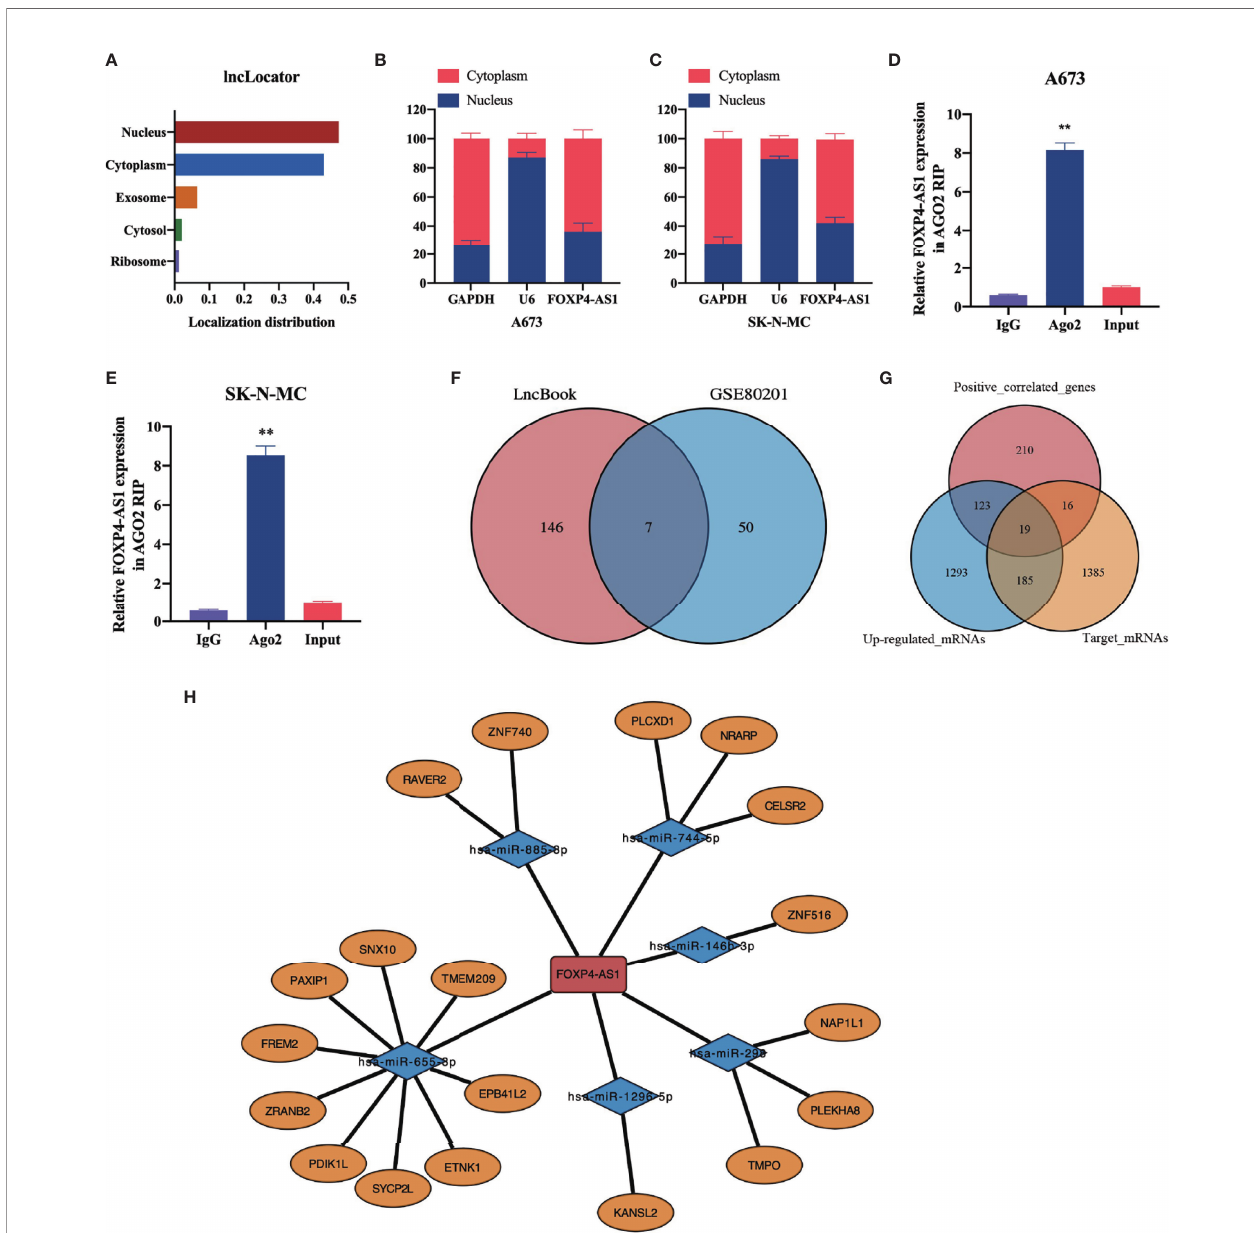
FIGURE 6 | Construction of a ceRNA modulatory network of FOXP4-AS1 in ES. (A) The subcellular localization of FOXP4-AS1 was predicted by the lncLocator tool. (B, C) Subcellular localization of FOXP4-AS1 was analyzed by nuclear and cytoplasmic separation experiments in A673 and SK-N-MC cells. (D, E) Ago2-IP experiment revealed that FOXP4-AS1 can bind to Ago2 and participate in the miRNA-mediated mRNA silencing function. Input represents a sample of the solubilized membranes prior to incubation with the antibody-bound beads. (F) Prediction of target miRNAs for FOXP4-AS1 using LncBook. The predicted miRNAs were combined with those down-regulated in Ewing sarcoma to reveal seven miRNAs that were fi nally incorporated into the ceRNA network. (G) Target mRNAs of 7 ceRNA-miRNAs were predicted using miRDB and Targetscan databases. Up-regulated mRNAs (logFC> 0.5, adj.p.value <0.05) were obtained through ES microarray data. We incorporated the intersection between the three gene sets (predicted target mRNAs, up-regulated mRNAs, FOXP4-AS1 positively correlated genes) into the ceRNA network, and obtained a total of 19 potential ceRNA-mRNAs. (H) Visualization of the ceRNA network using Cytoscape. **p <